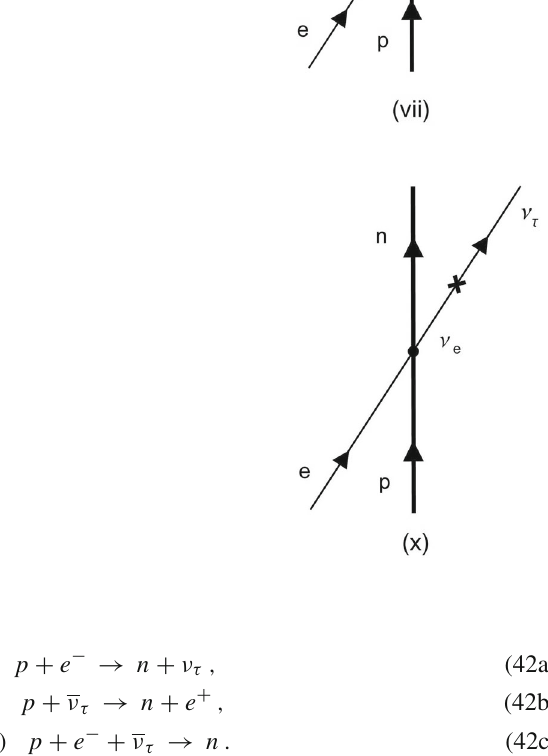
Fig. 4 Inverse β -decay in the comoving frame in the presence of flavor oscillations (time flows in the vertical direction). The crosses denote the occurrence of the